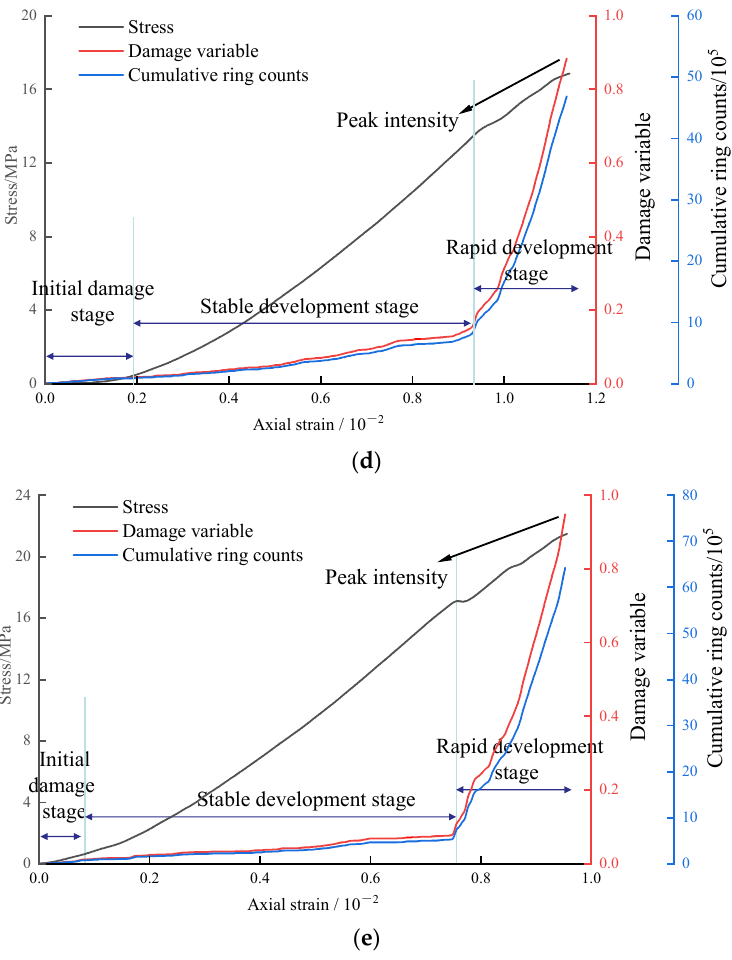
Figure 9. Variation Characteristics of damage variables of coal samples under different loading rates: ( a ) V = 0.002 mm/s ( b ) V = 0.006 mm/s ( c ) V = 0.01 mm/s ( d ) V = 0.014 mm/s ( e ) V = 0.018 mm/s.